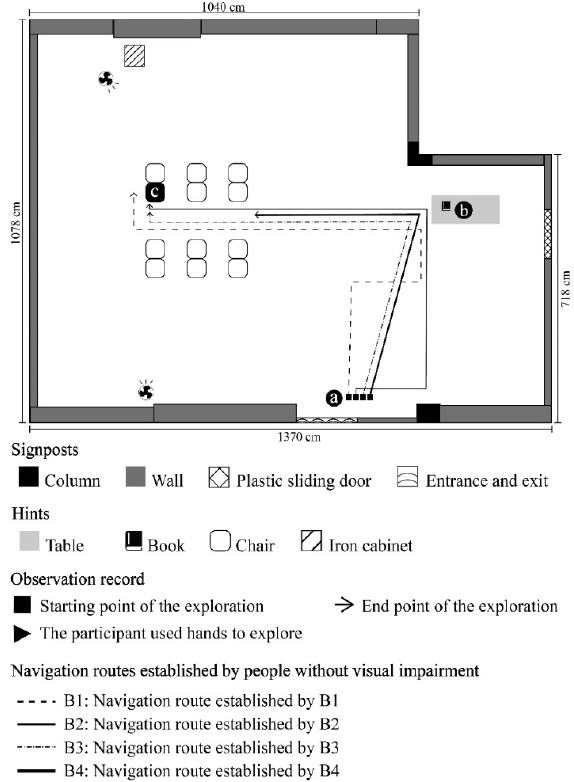
Int. J. Environ. Res. Public Health 2022 , 19 , x FOR PEER REVIEW Figure 6. A4 participant’s route of movement at each stage. Figure 6. A4 participant’s route of movement at each stage.